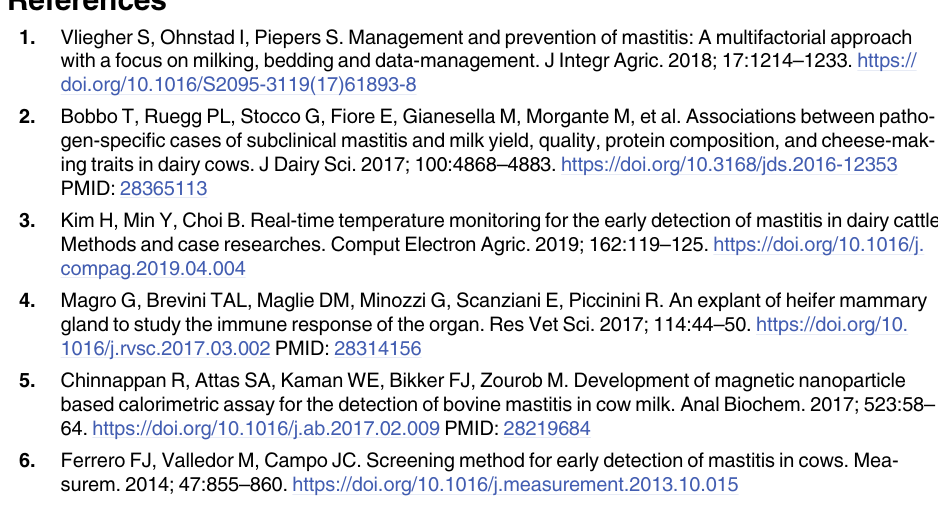
S1 Fig. Data that originated Fig 3. S2 Fig. Data that originated Figs 3 and 5. S3 Fig. Data that originated Fig